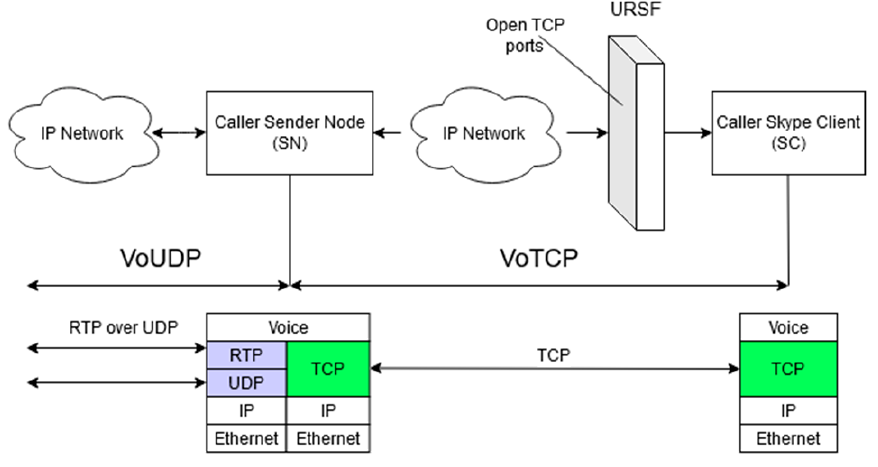
Figure 1. Diagram showing the VoTCP mechanism used by Skype. Recreation from Yang, Lee and Ko (2008).